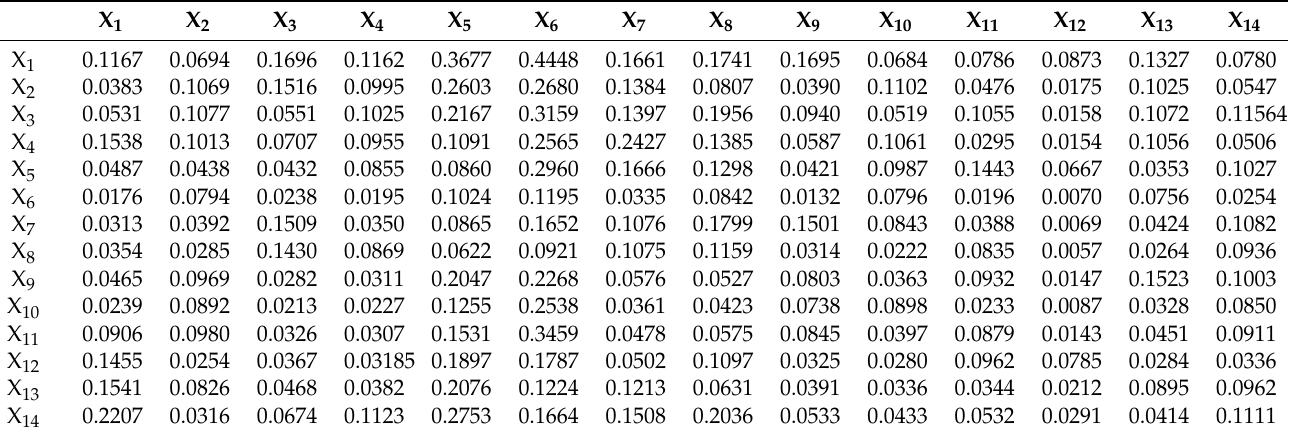
Table 4. Synthesis impact matrix.